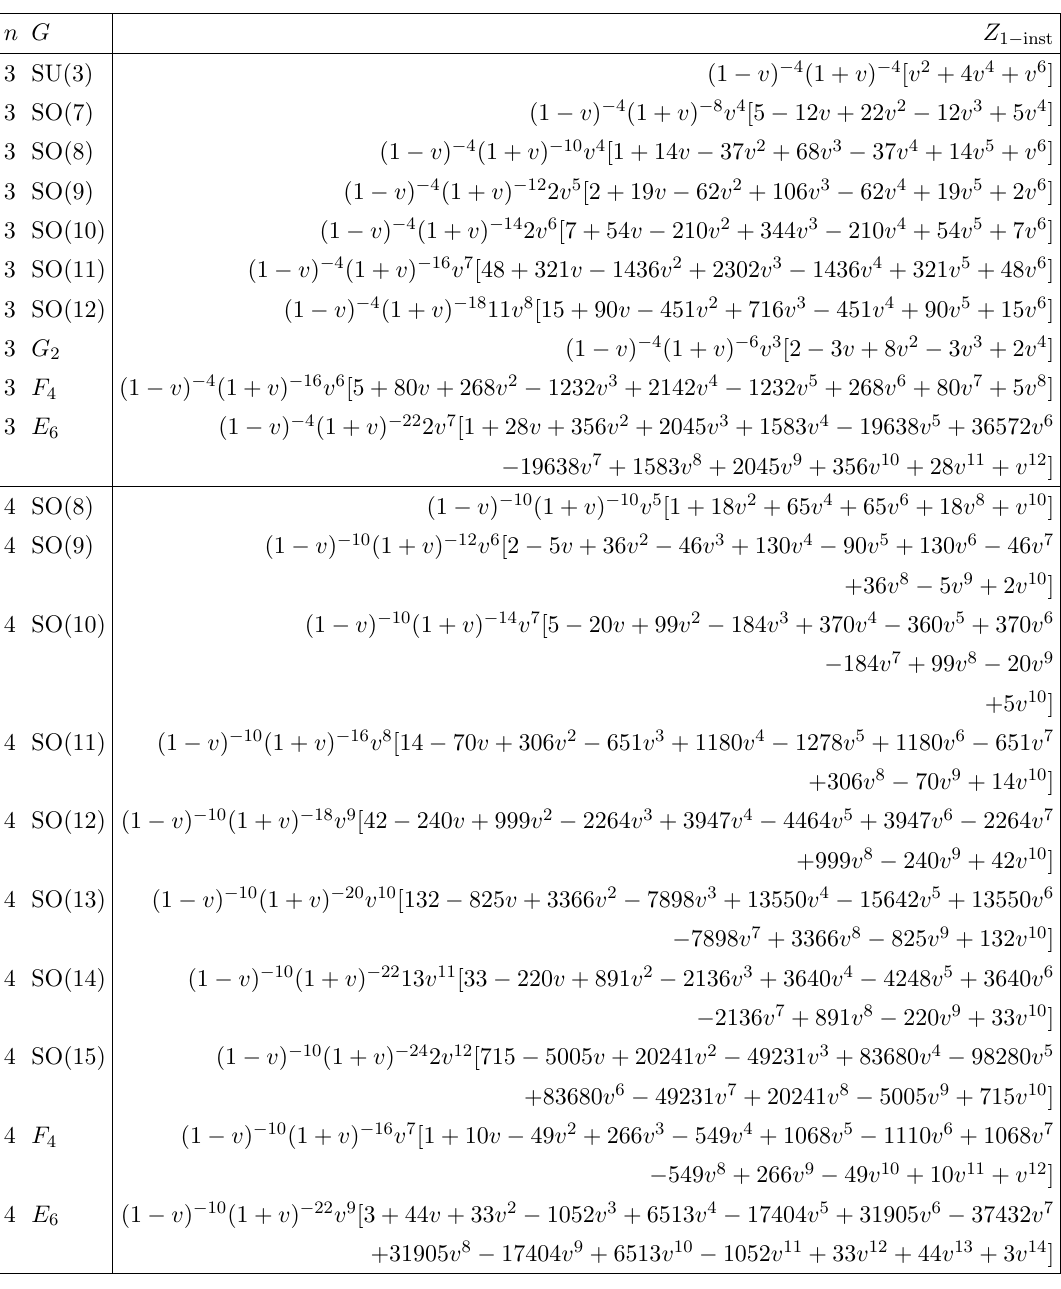
with n = 3 and 4, with n